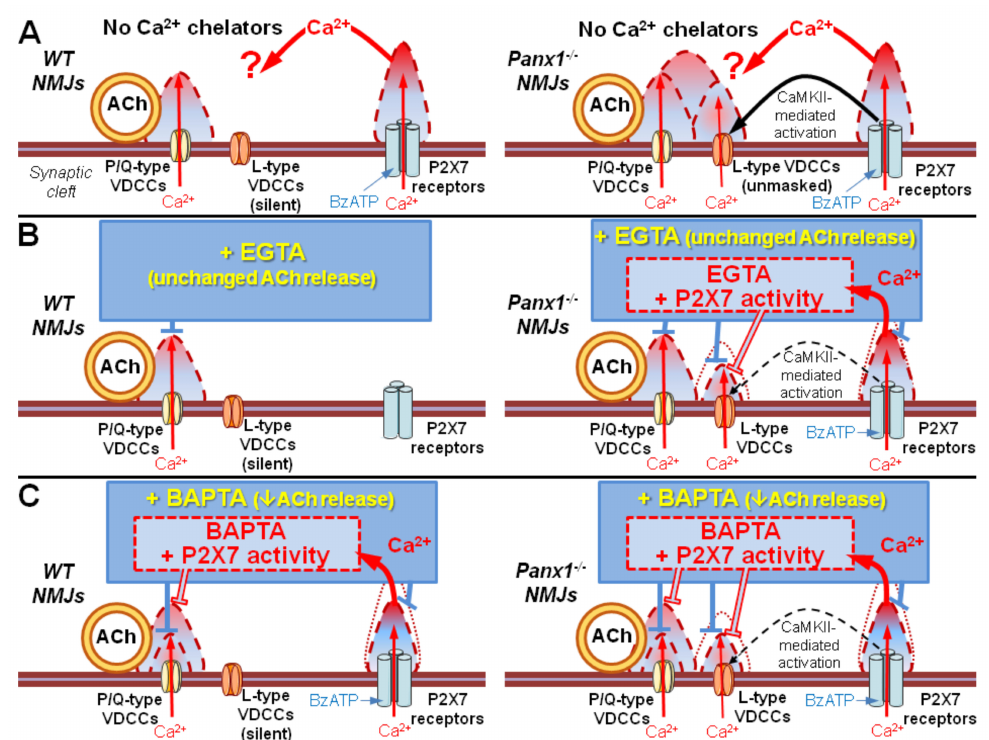
Figure 7. Suggested contributions of various presynaptic Ca 2 + inputs, interacting with slow or fast Ca 2 +